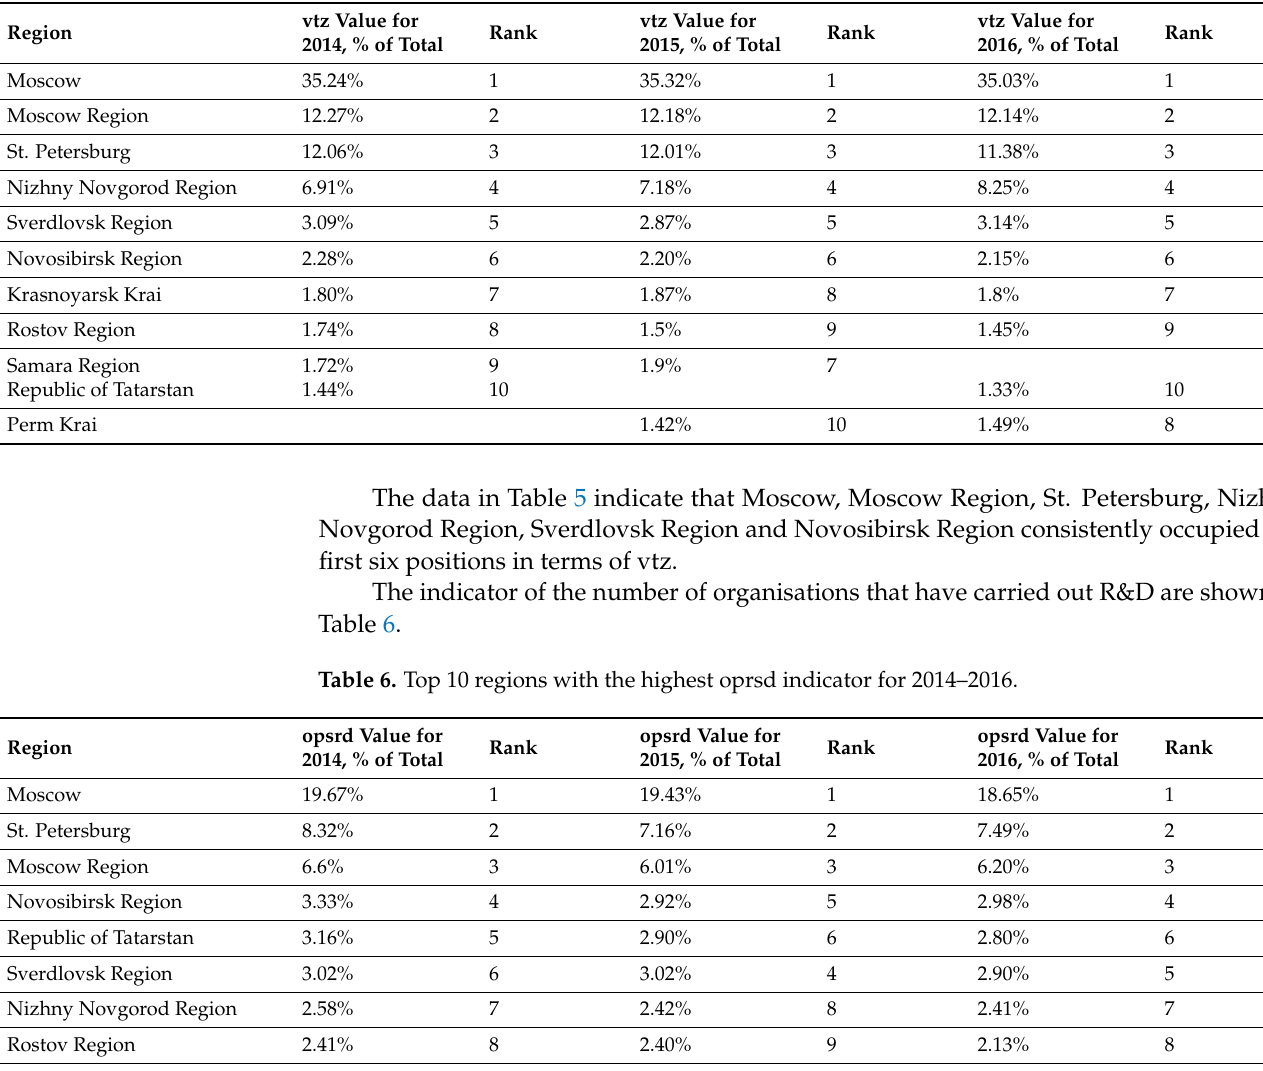
Table 5 presents the list of the top 10 regions with the highest vtz for 2014–2016. Table 5. Top 10 regions with highest vtz for 2014–2016.